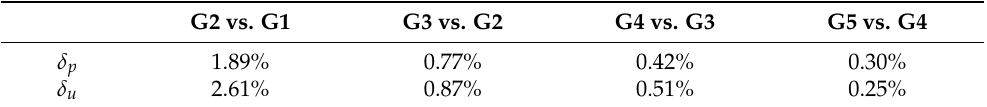
Table 2. Percentage variation of the pressure drop δ p and percentage mean deviation of the mi- crochannel velocity distribution δ u between two successive